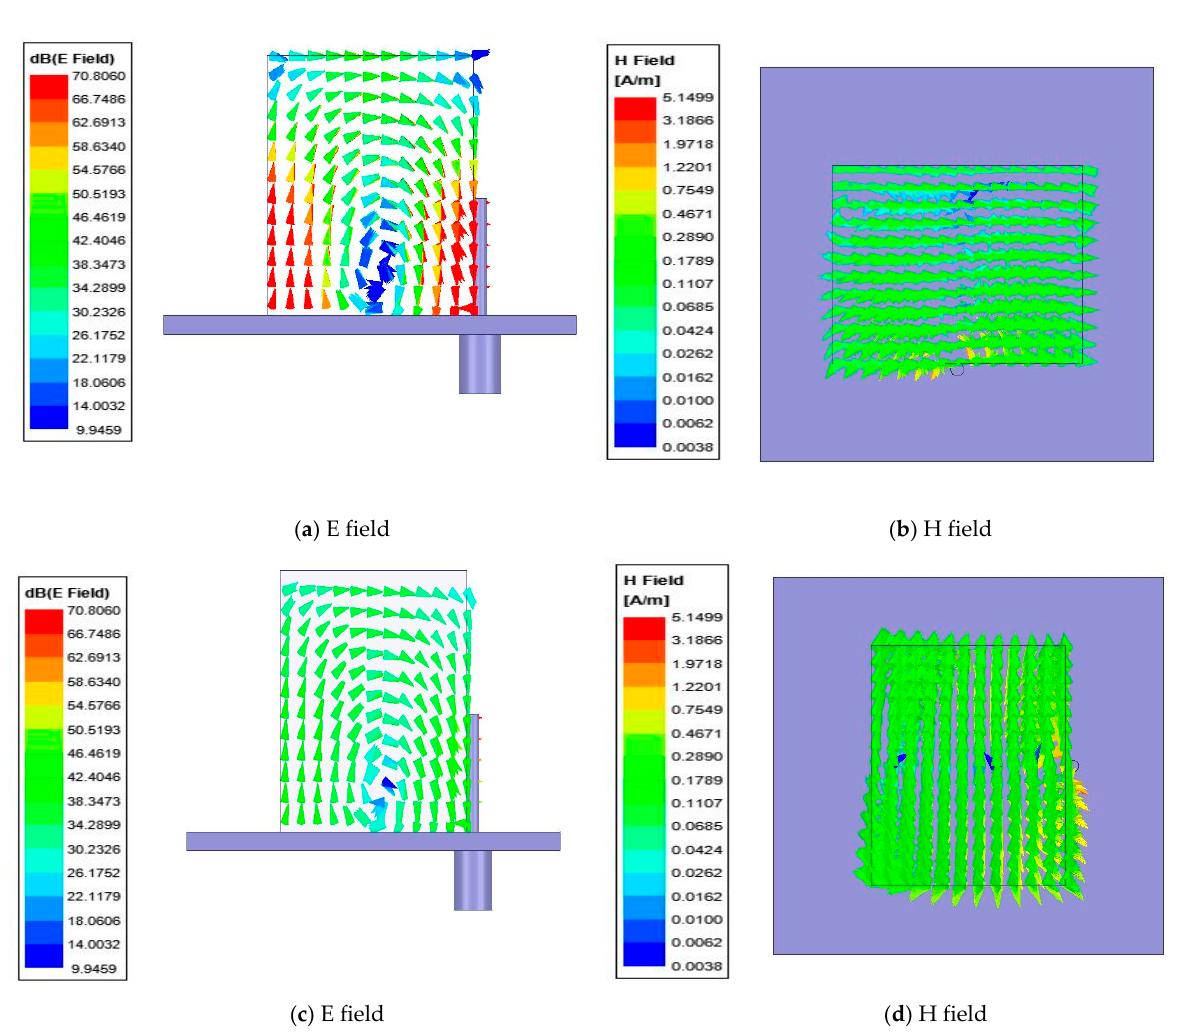
Figure 3. Field distribution inside the DR ( a , b ) H-plane configuration and ( c , d ) E-plane